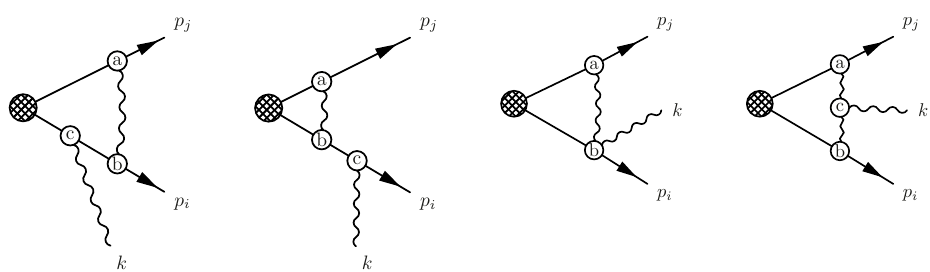
component. For i − k